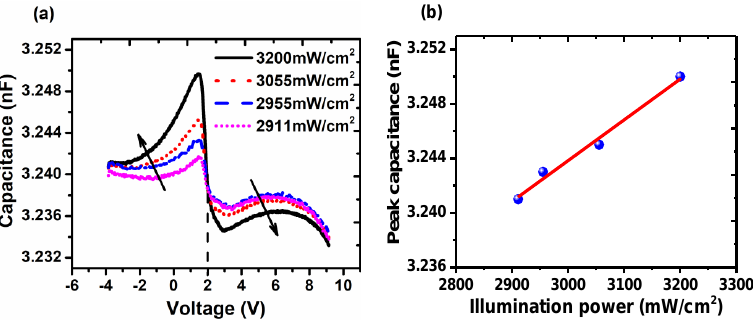
Figure 5. ( a ) The C-V characteristics for device with 6nm PMMA under different illumination power ( b ) The relation between the value of first peak and illumination power.